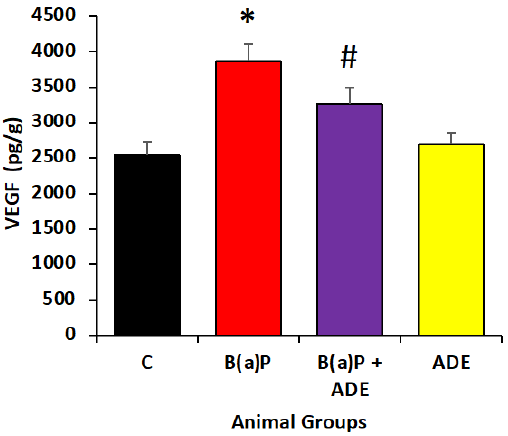
Figure 6. The angiogenic marker (VEGF) level in the different treatment groups. The values indicate the mean ± SEM, with 8 animals/group. In the B(a)P group, level of VEGF was significantly higher as compared to the control groups. The treatment with ADE significantly decreased the VEGF level ( p < 0.05). The significant differences ( p < 0.05) are represented by an asterisk (*) between the control group and B(a)P groups and (#) between the control group and B(a)P+ Ajwa date extract (ADE) groups.